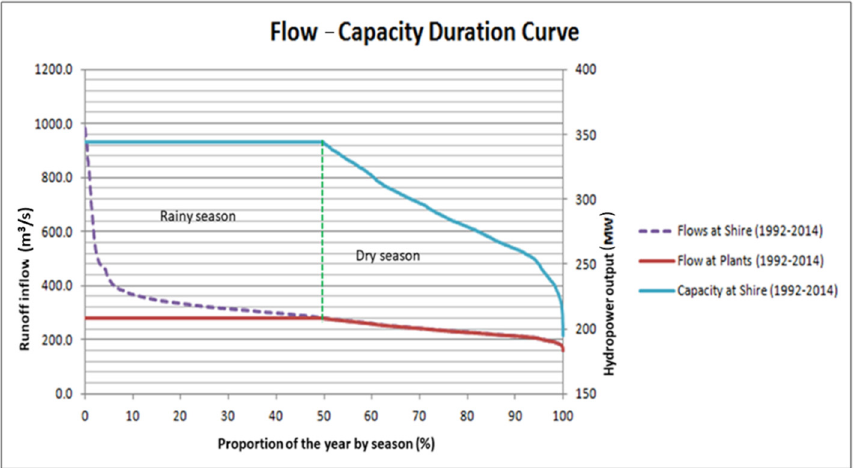
Figure 5. Flow/capacity duration curve for the Shire River in rainy (January–May) and dry (July– December) seasons.